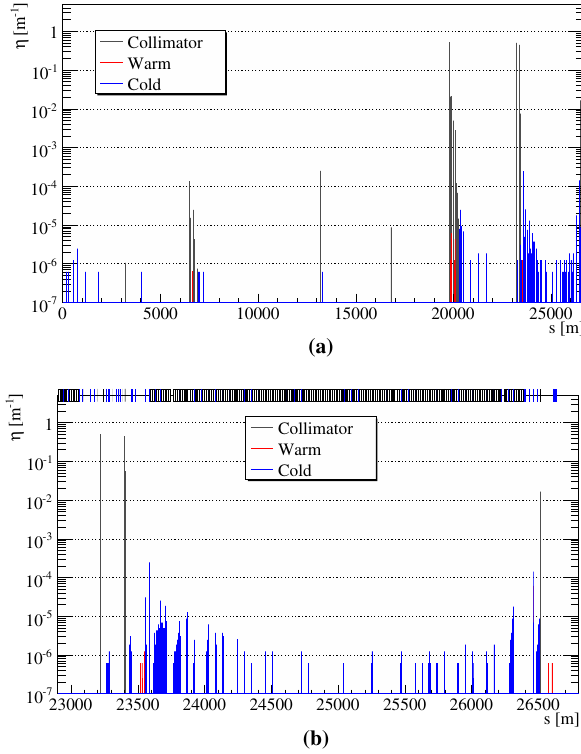
Fig. 6 Simulatedbeam-losspatternfortheIR8layoutwithCry 1 at5 σ . The whole LHC ( a ), zoom of the arc 81 ( b ) (1 p = 6 . 2 × 10 − 7 m − 1 )